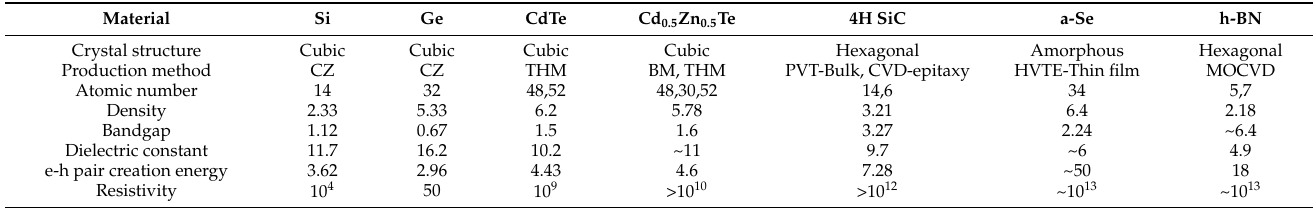
Table 2. Physical parameters comparison for different semiconductor materials